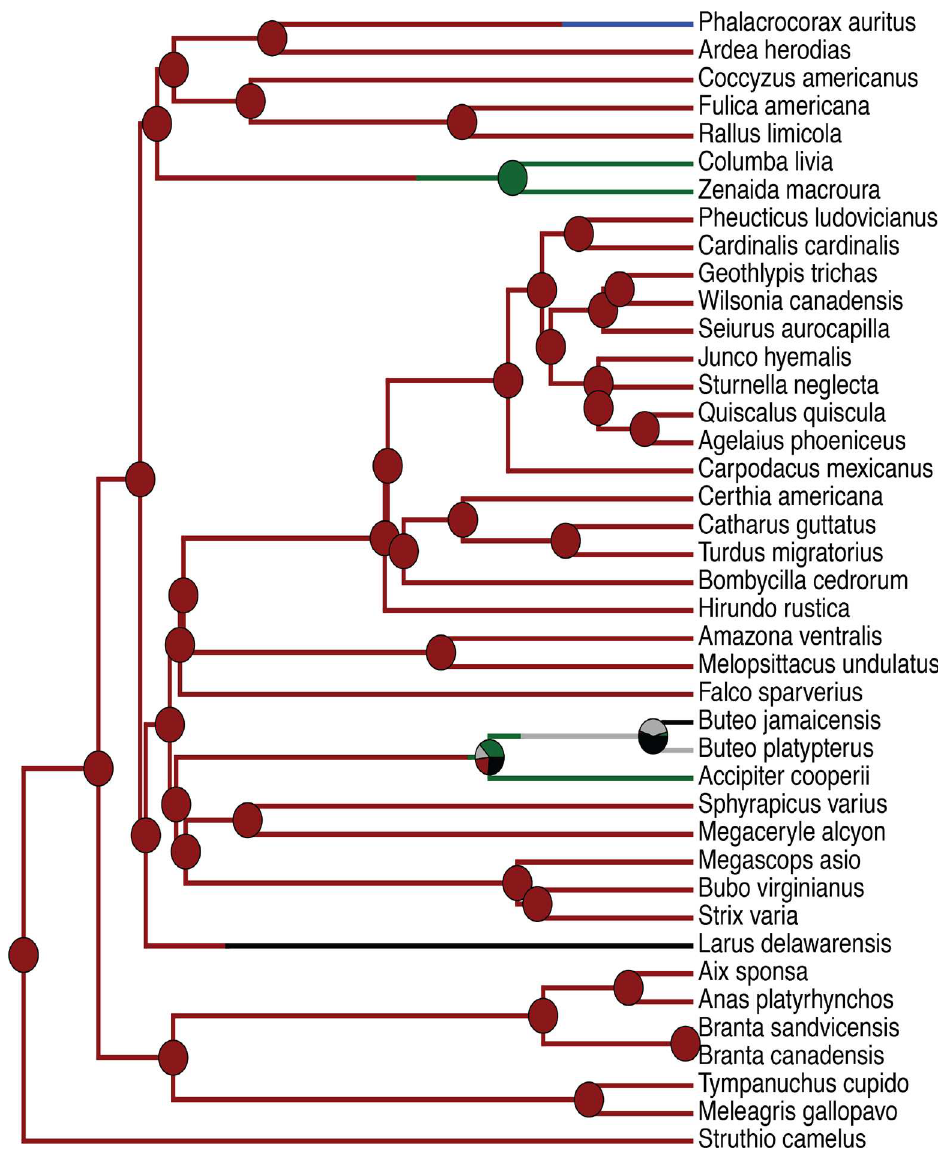
Fig 3. Ancestral statereconstructionphylogeny of trachealdisplacement. For ease of understanding trachealplacements in bird taxa. Esophageal placement has, essentially, almostno variabilityand so is not plotted.Red = rightlateral;green = left lateral;black = rightlateral and left lateral;blue = rightlateraland midsagittal; gray = midsagittal.